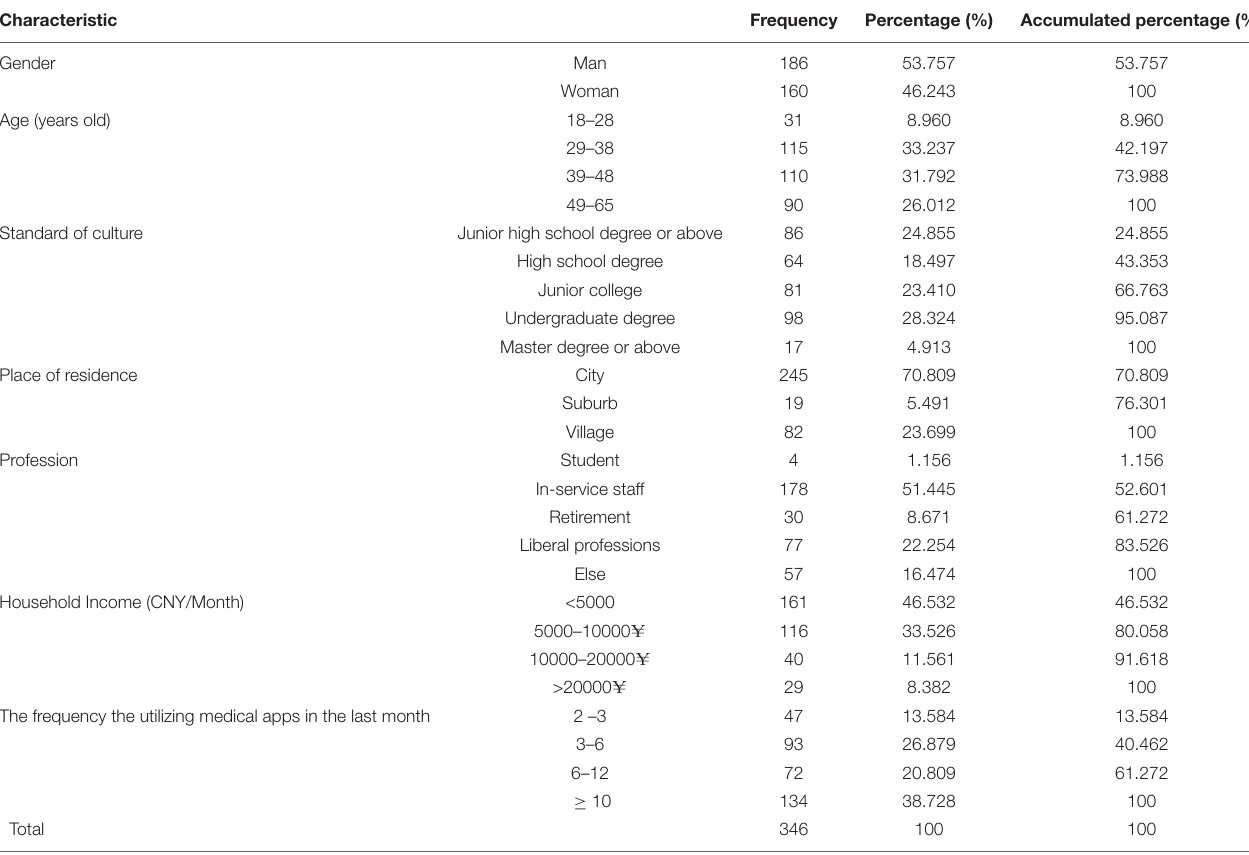
TABLE 1 | Subjects’ demographic characteristics ( n =